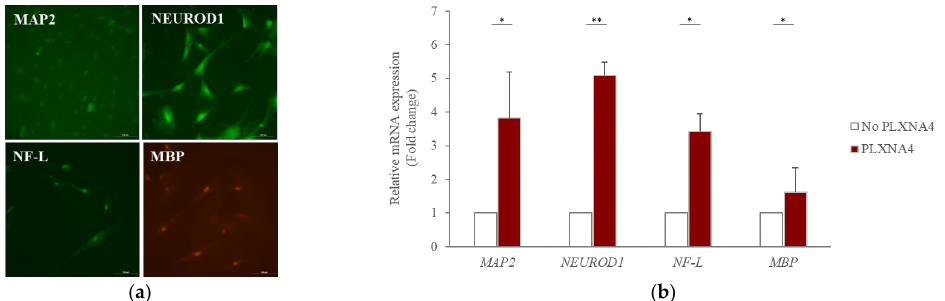
Figure 5. Expression of neuron-related proteins and genes in human umbilical-cord-derived mesenchymal stem cells after recombinant PLXNA4 protein treatment. Cells were harvested 5 days after 2 μ g/mL recombinant PLXNA4 protein treatment. ( a ) Fluorescence images of each protein.